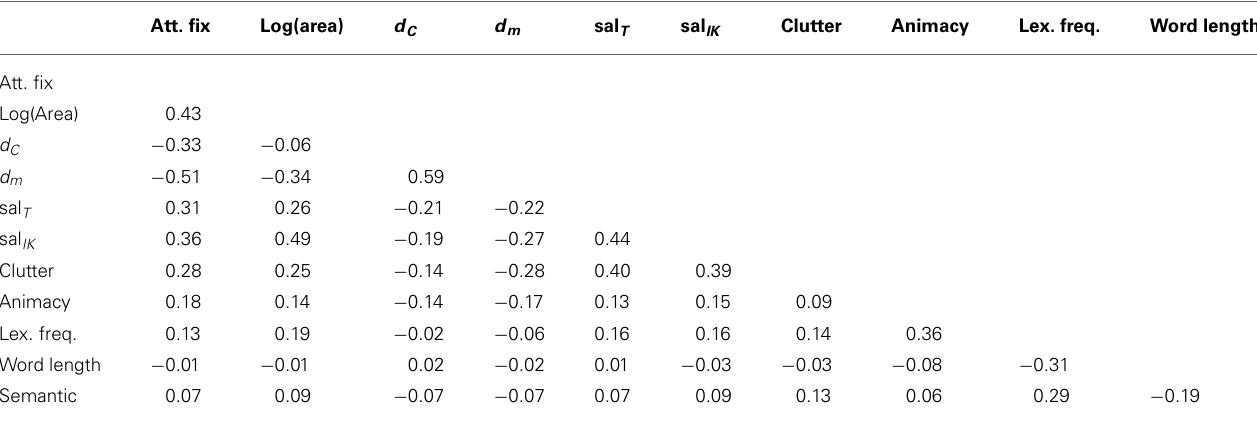
Table A1 | Spearman ( ρ ) correlation across measures of all features introduced in our linear regression models. Att. fix Log(area) d C d m sal T sal IK Clutter Animacy Lex. freq. Word